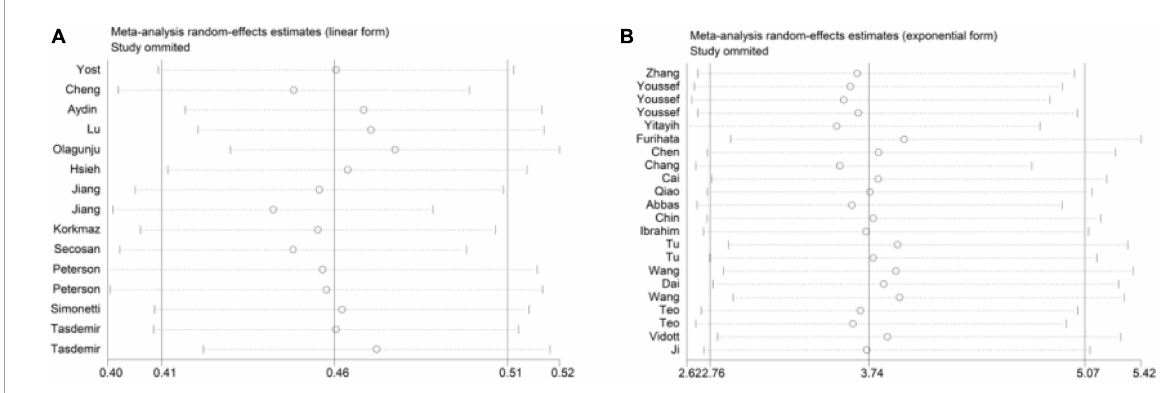
FIGURE4 Sensitivity analysis. (A) The studies were extracted. (B) The studies were extracted OR.